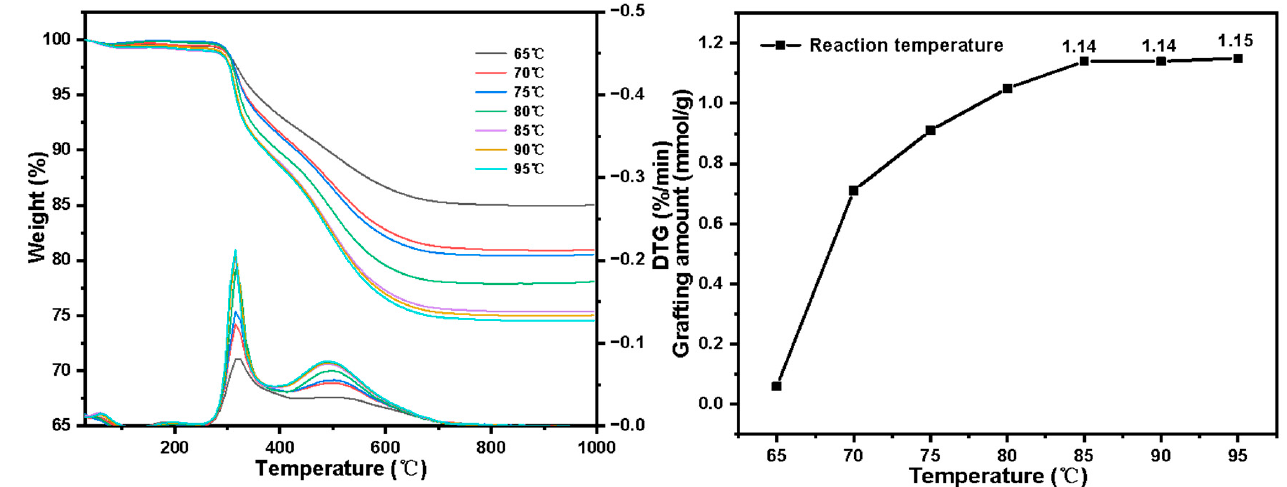
Figure 12. Grafting amount varies with 4-VP reaction temperature. Influence of initiator dosage on grafting amount: